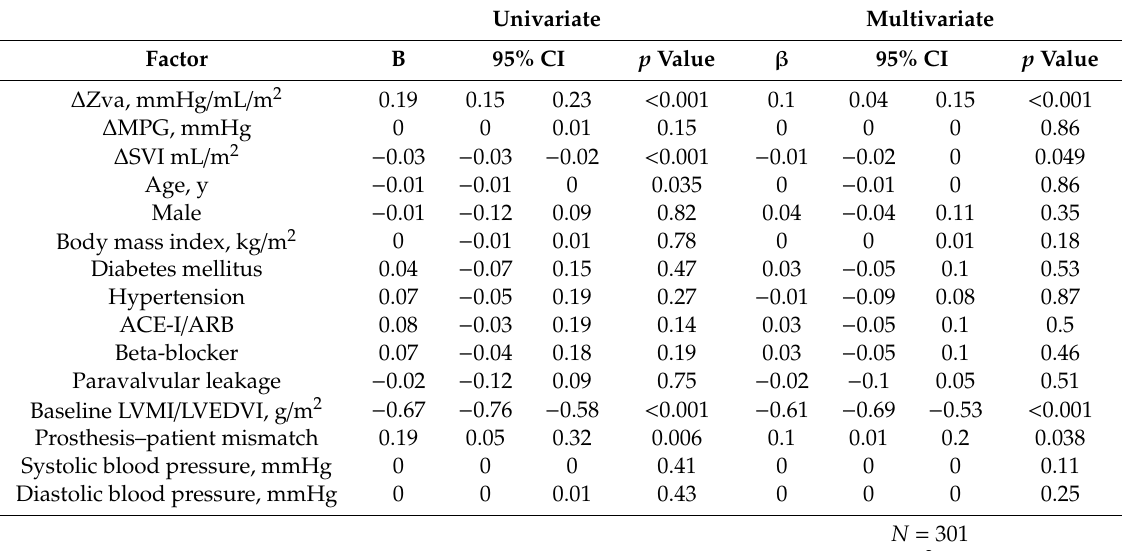
Table 5. Univariate and multivariate linear regression analyses to identify factors associated with ∆ LVMI / LVEDVI. Univariate Multivariate Factor B 95% CI p Value β 95% CI ∆ Zva, mmHg / mL / m